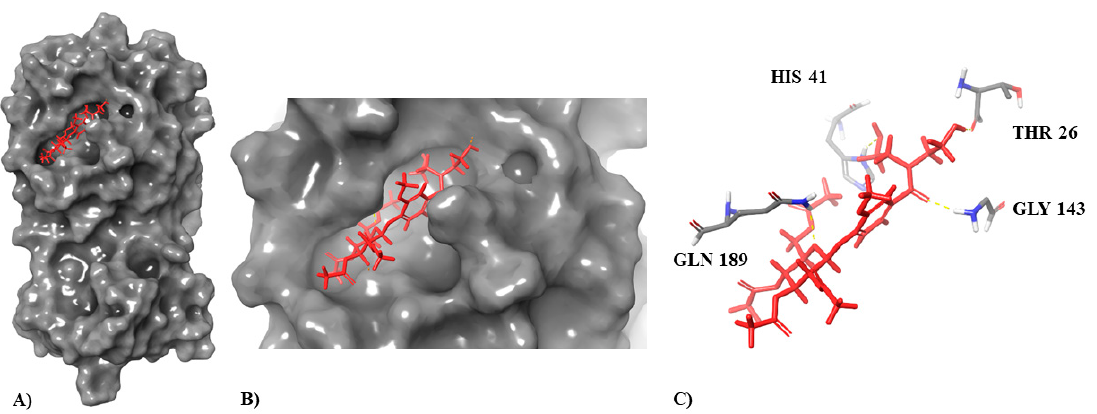
(Figure 2A). Of all potential anti-SARS-CoV-2 compounds selected by Molecular Topology stands Molport-046-067-769 as the one with higher binding affinity for 6LU7 binding pocket (docking score: − 7.514) (Figure 8), closest to co-crystallized ligand inhibitor N3 (docking score: − 8.019). This compound establishes interactions with four of the five amino acids (AAs) with which the co-crystallized ligand interacts with Mpro (Inhibitor N3) named Thr26, Gln189, Glu166, and Gly143 (Table 6). All AA interactions with Mpro binding pocket from all reported potential anti-SARS-CoV-2 are reported in Table 6.